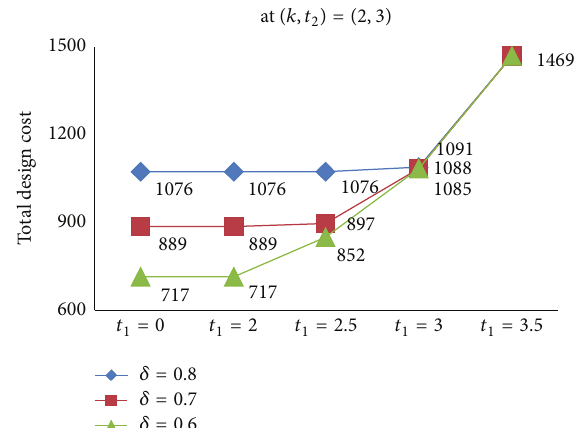
Figure 10: Variation of total design cost with 𝑡 1 for various 𝛿 values.